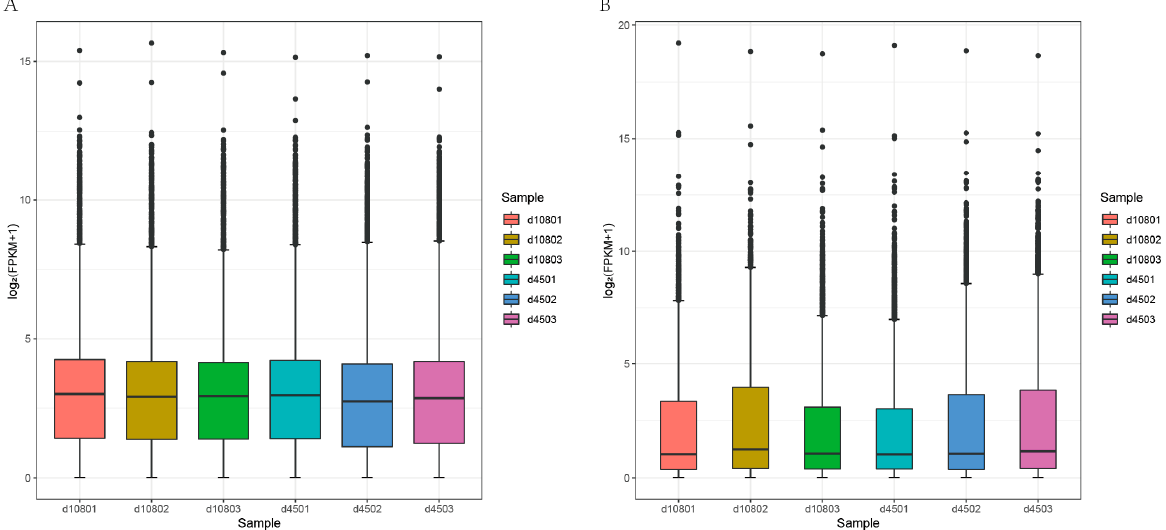
Figure 3. The expression of mRNAs and lncRNAs in six samples at two developmental stages: ( A ) mRNAs expression; ( B ) lncRNAs expression.